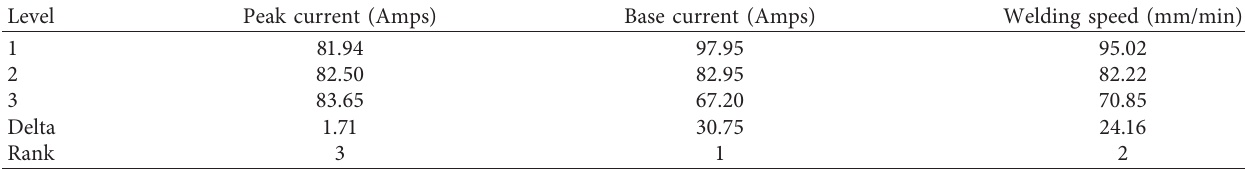
Table 8: Response table for tensile strength means (larger is better).